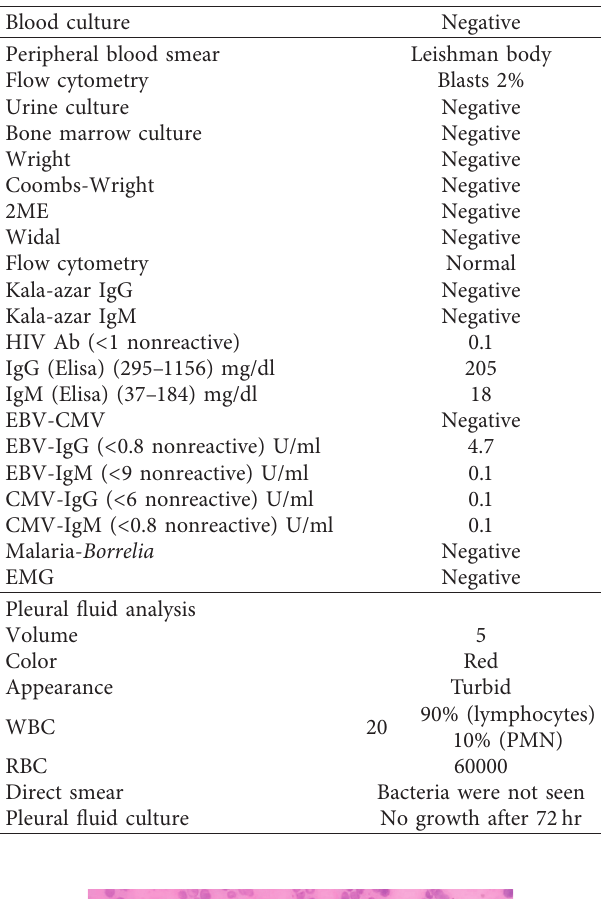
Table 2: Other laboratory findings to rule out different differential diagnosis.